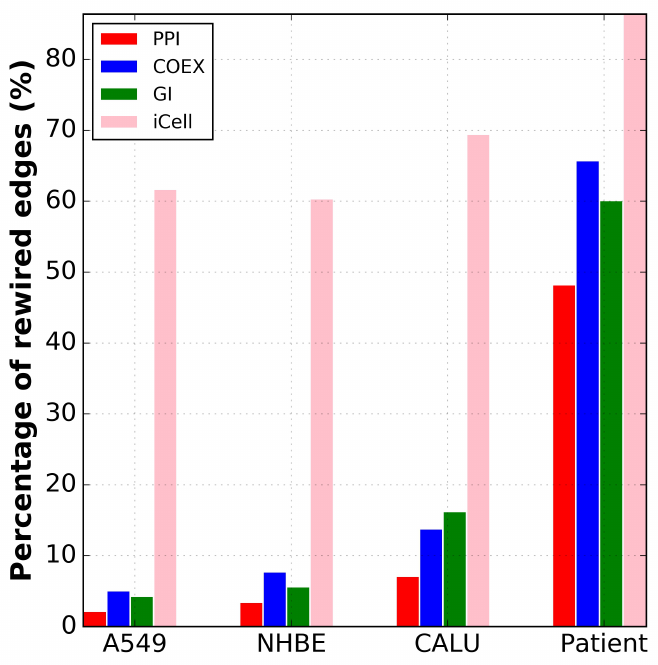
Figure 3. Only iCells are intensely rewired in COVID-19. For each cell line and the patient data (x-axis) and for each type of network (color coded), the percentage of rewired edges (y-axis) between the infected and the control networks is